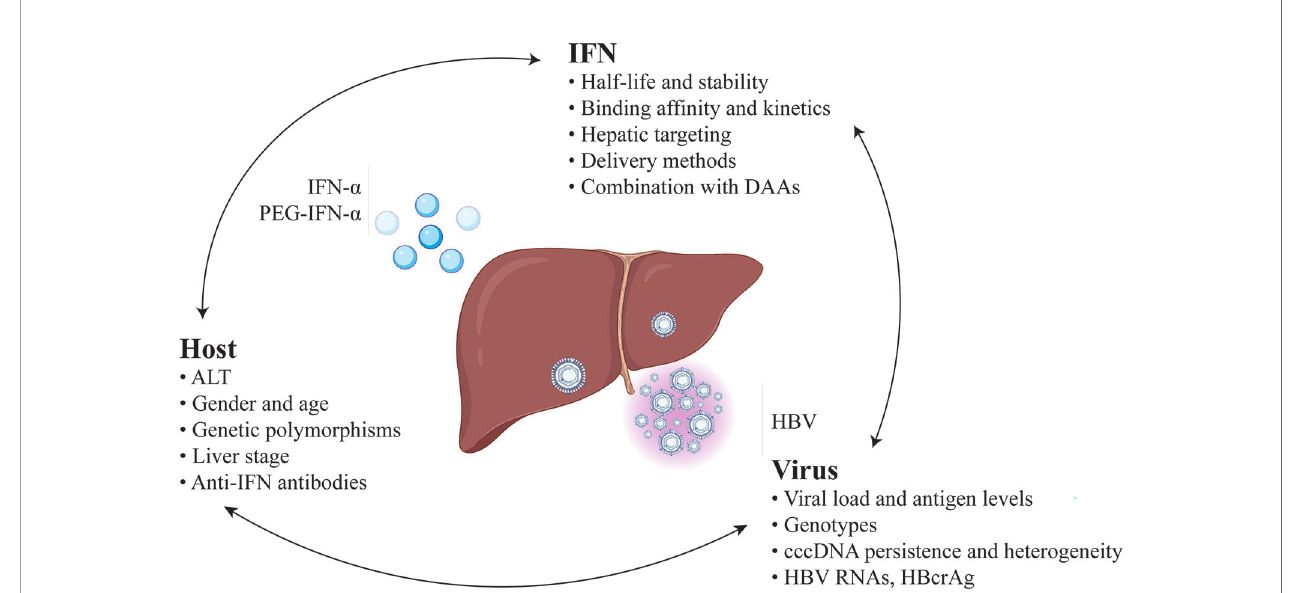
FIGURE 1 | Predictors and strategies for improvement of the ef fi cacy of IFN-based therapy for chronic hepatitis